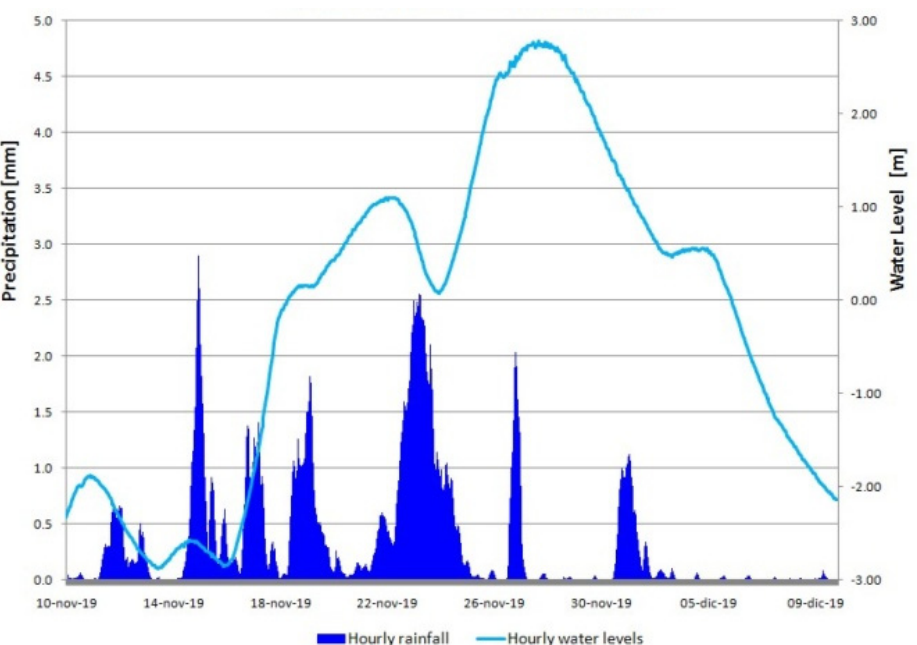
Figure 6. Po River at Pontelagoscuro. Observed mean areal precipitation and water level during a flood event in 2019.